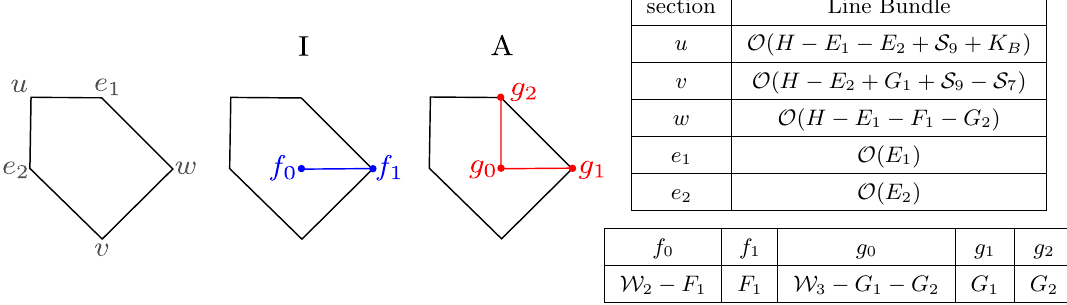
ambient space as well as the top 11